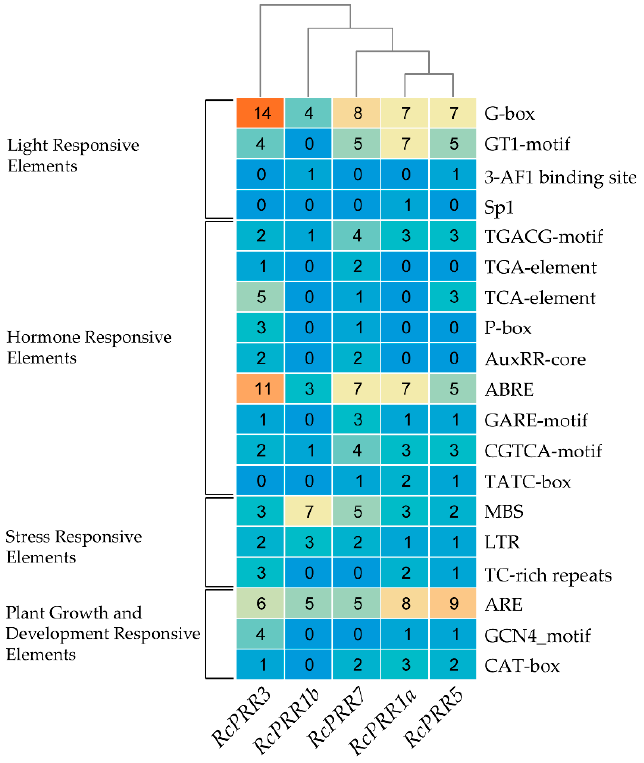
Figure 4. cis -regulatory elements present in the promoter region of clock PRRs of rose.